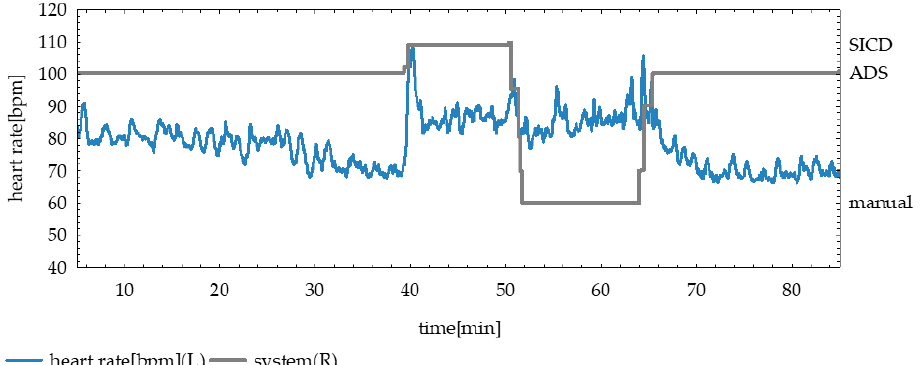
Figure 5. Example for change of heart rate for automated drive (ADS), during the SICD and during the manual drive and back to ADS. The driver was asleep during the automated drive (ADS).